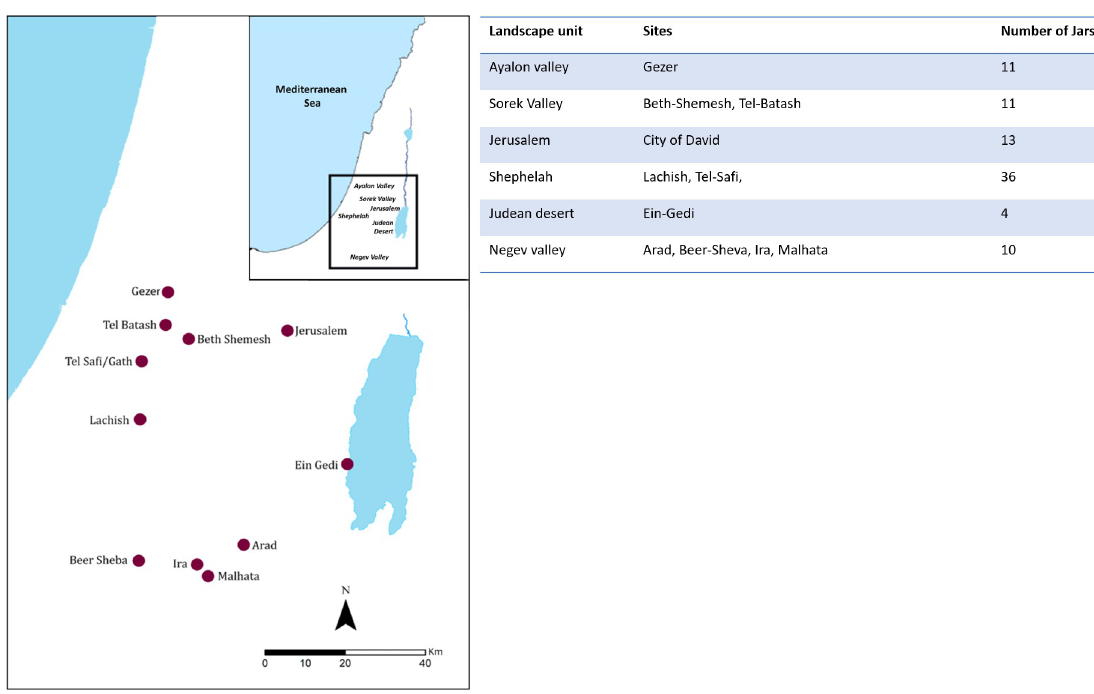
Fig 2. Distribution map with ARCMAP of the lmlk and the Rosetta- jar assemblages analyzed in this study (left), and the number of jars per landscape unit and site (right).